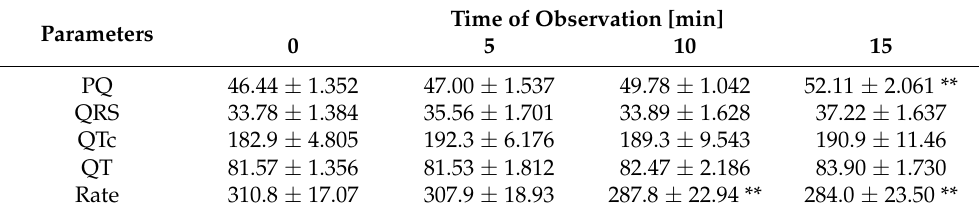
Table 2. Effects of an intravenous injection of the S-75 at dose 5 mg/kg on heart rate and ECG